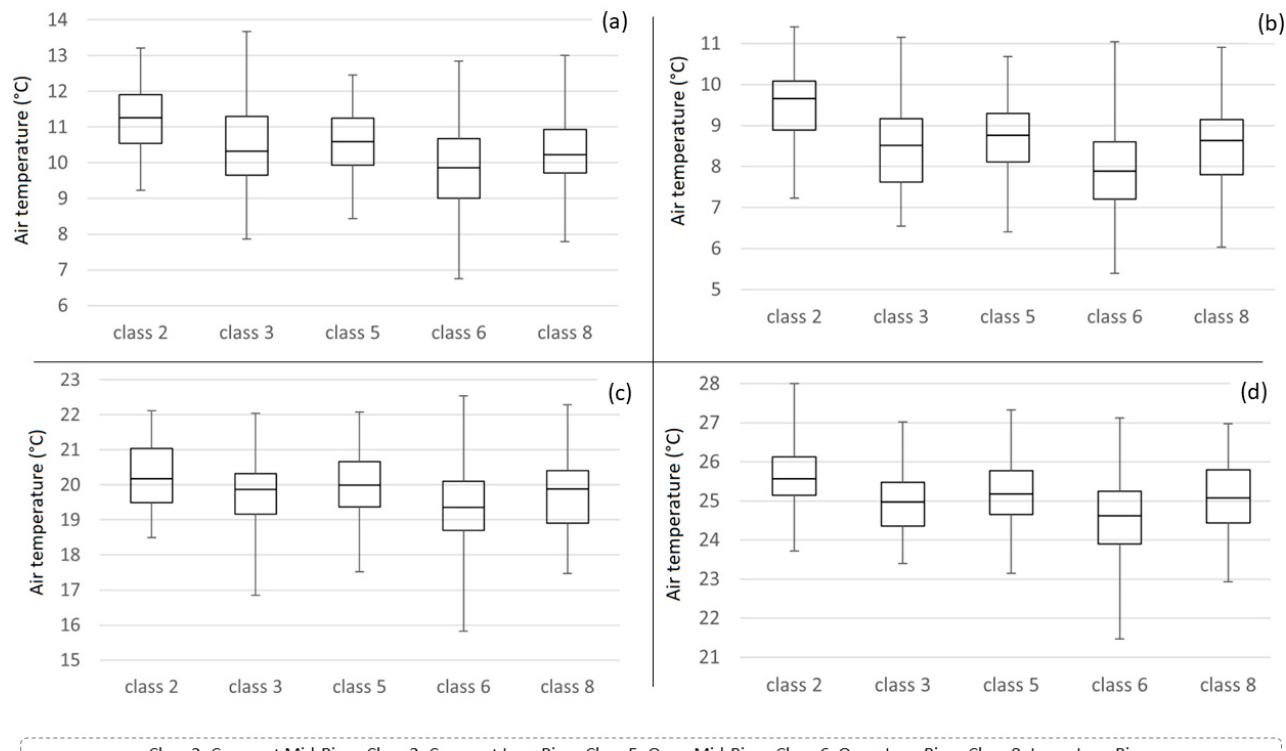
Figure 11. Boxplots of air temperature values per class in the four seasons (all observations in the period 2018–2021): ( a ) autumn, ( b ) winter, ( c ) spring , ( d ) summer. Table 9. Results of the t -tests and values of Cohen’s d for each pair of artificial classes in the four seasons (study period 2018–2021).